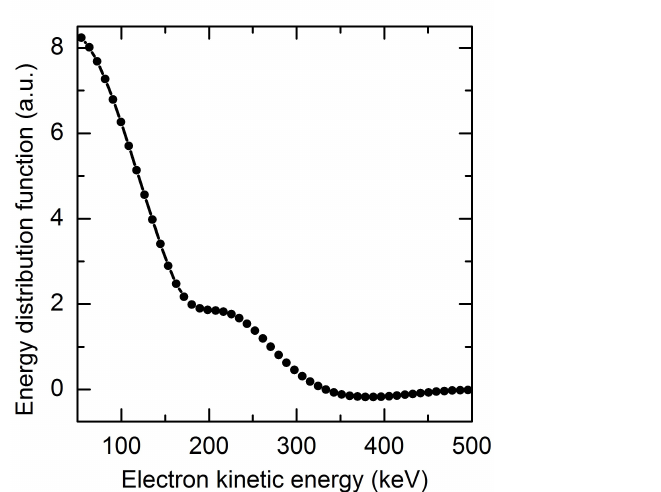
Figure 1 – Experimentally reconstructed fast electron spectrum in the vacuum diode Рис. 1 – Восстановленный экспериментальный спектр быстрых